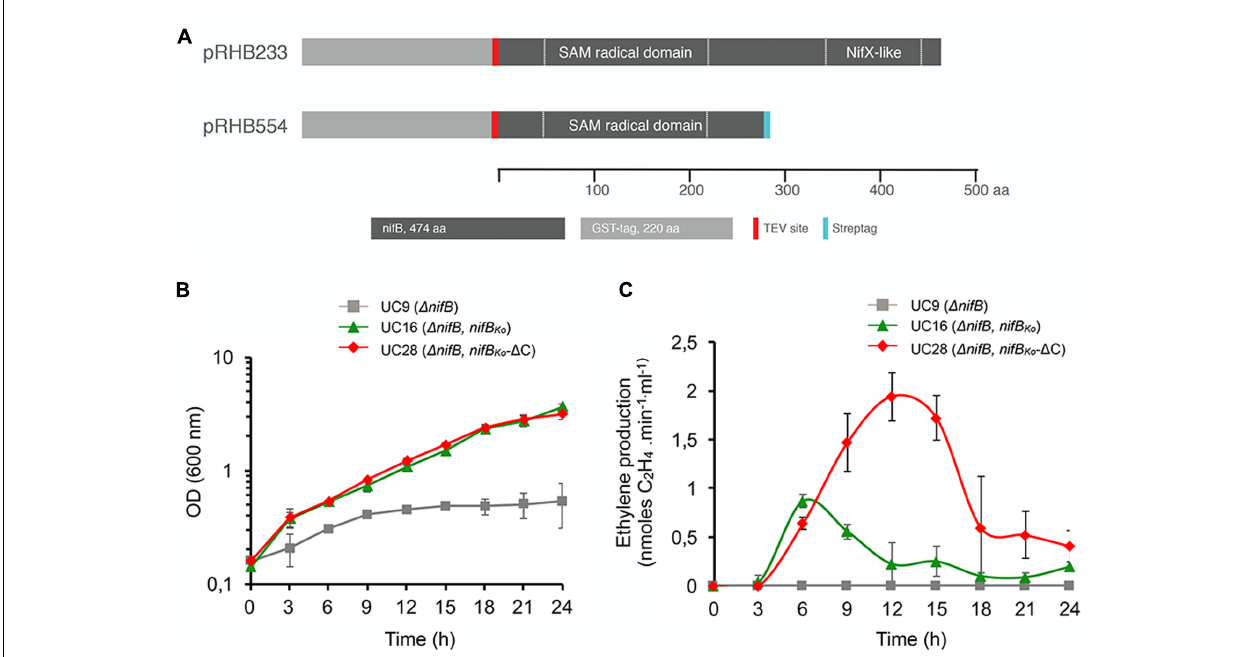
FIGURE 5 | (A) Scheme of full-length GST-NifB Ko and GST-NifB Ko - (cid:49) C in expression plasmids carried by UC16 and UC28, respectively. (B,C) Diazotrophic growth (B) and in vivo acetylene reduction activity (C) of K. oxytoca UC16 and UC28 expressing full-length and truncated NifB variants, respectively, compared to the UC9 ( (cid:49) nifB ) strain. Data represent means ± SD ( n = 3). Maximum ethylene production of K. oxytoca UN (wild-type) was 12.6 nmol · min − 1 · ml − 1 ( n = 3).